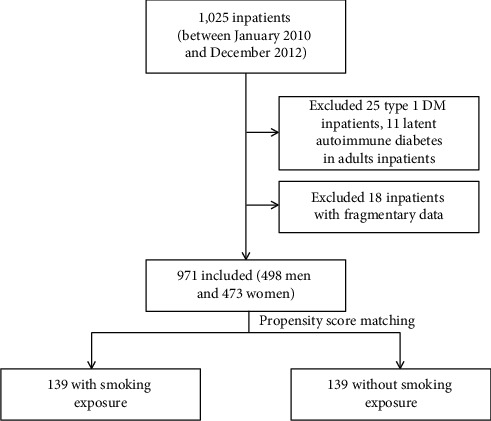
The flowchart of participants.